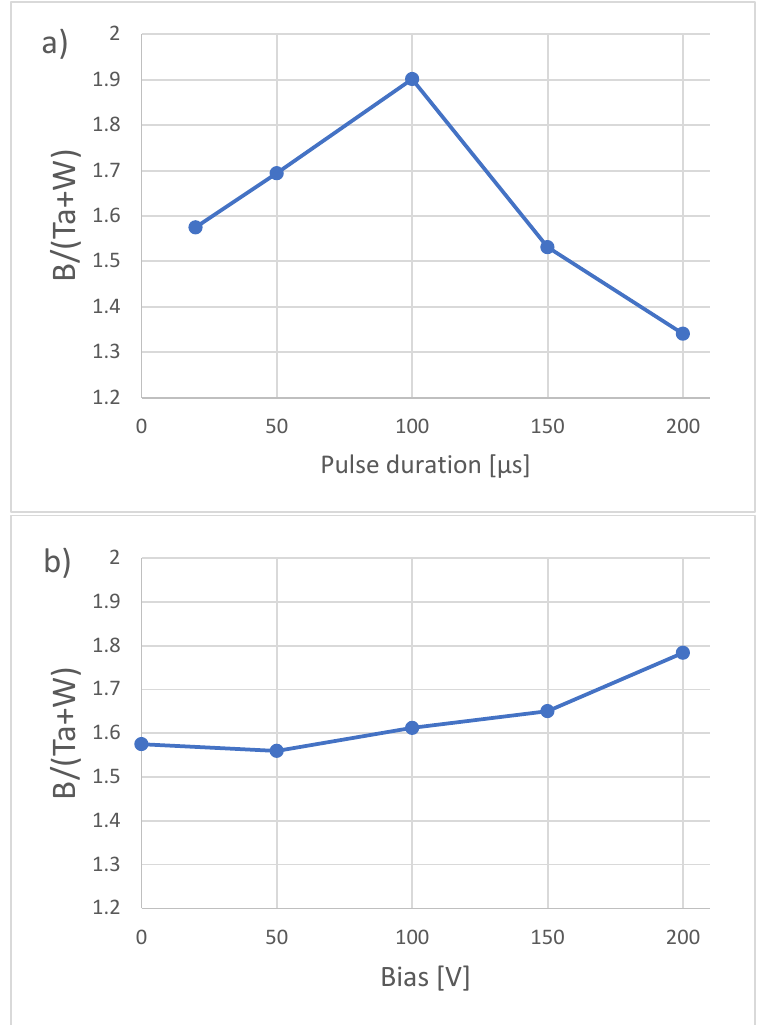
Figure 3. Ratio of boron to metals for different (a) pulse durations and (b) bias voltages.